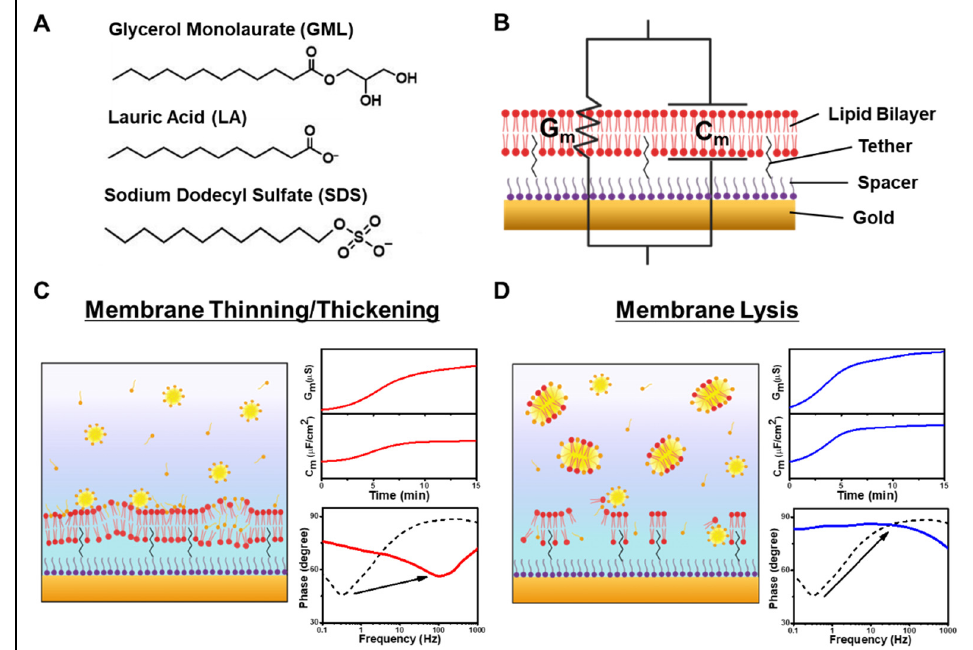
Figure 1. ( A ) Molecular structures of GML, LA, and SDS. ( B ) Schematic illustration of EIS measurement setup with the tBLM platform. The corresponding electrical properties of the tethered lipid bilayer are modelled in terms of conductance (G m ) and capacitance (C m ). ( C , D ) Schematic illustration of ( C ) membrane thinning/thickening and ( D ) membrane lysis effects and typical measurement responses.